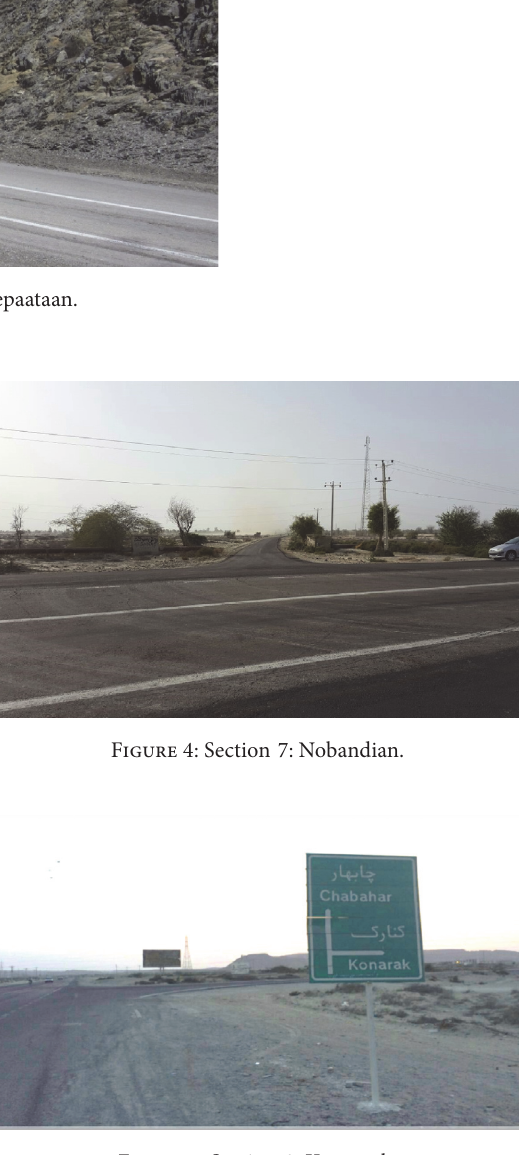
Figure 5: Section 8: